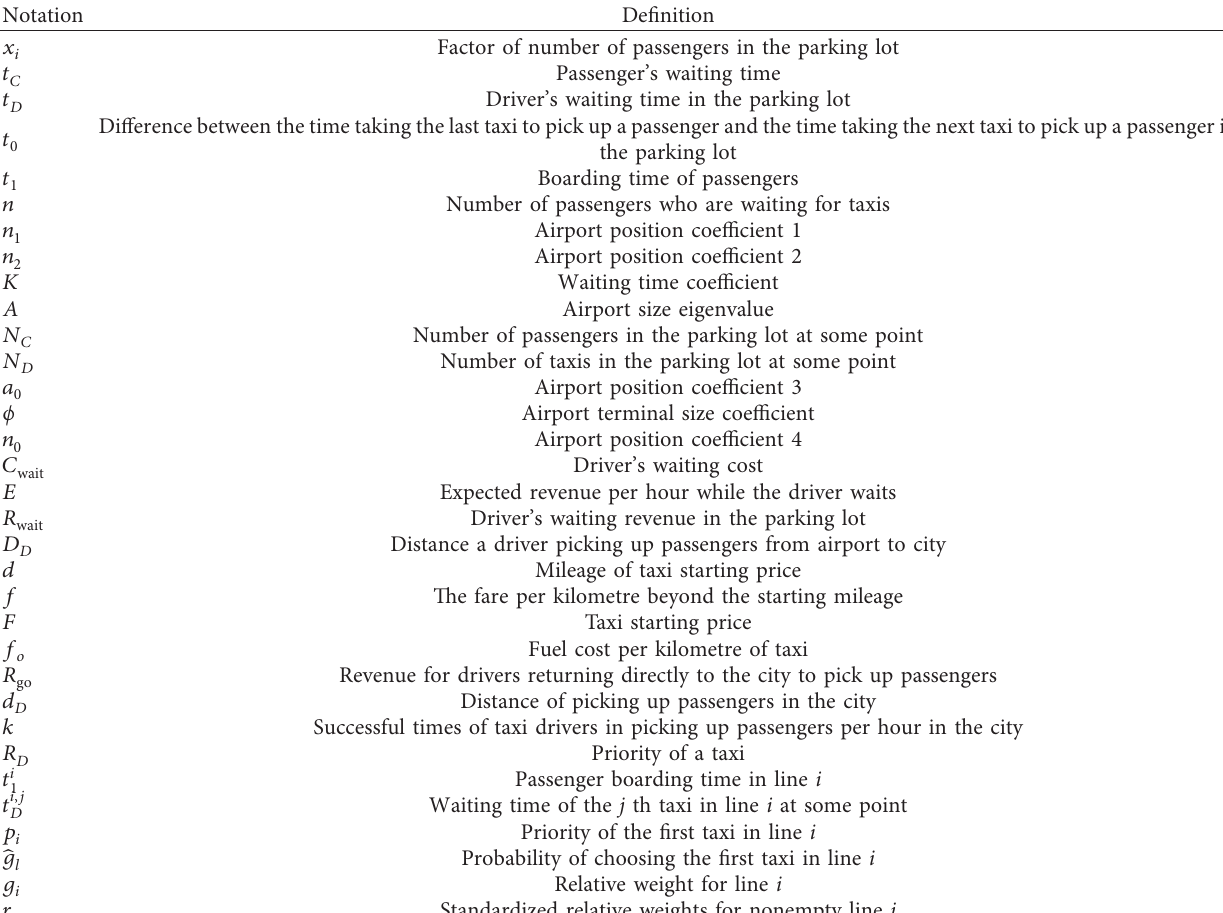
Table 1: Explanation for